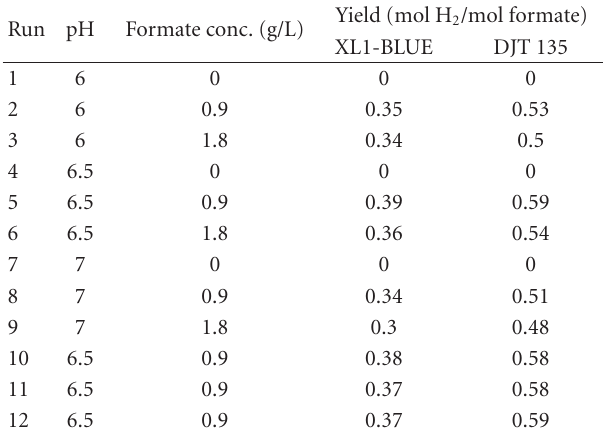
Table 2: The 3 2 experimental design matrix for evaluating